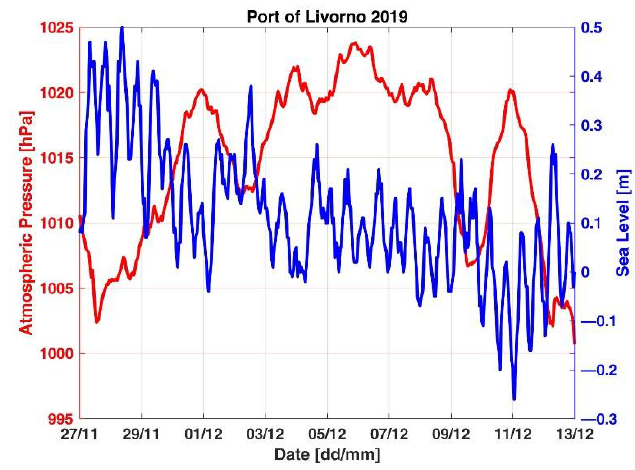
Figure 8. Meteomareographic parameters acquired by ISPRA’s monitoring station in the port of Livorno from 27 November to 13 December 2019.